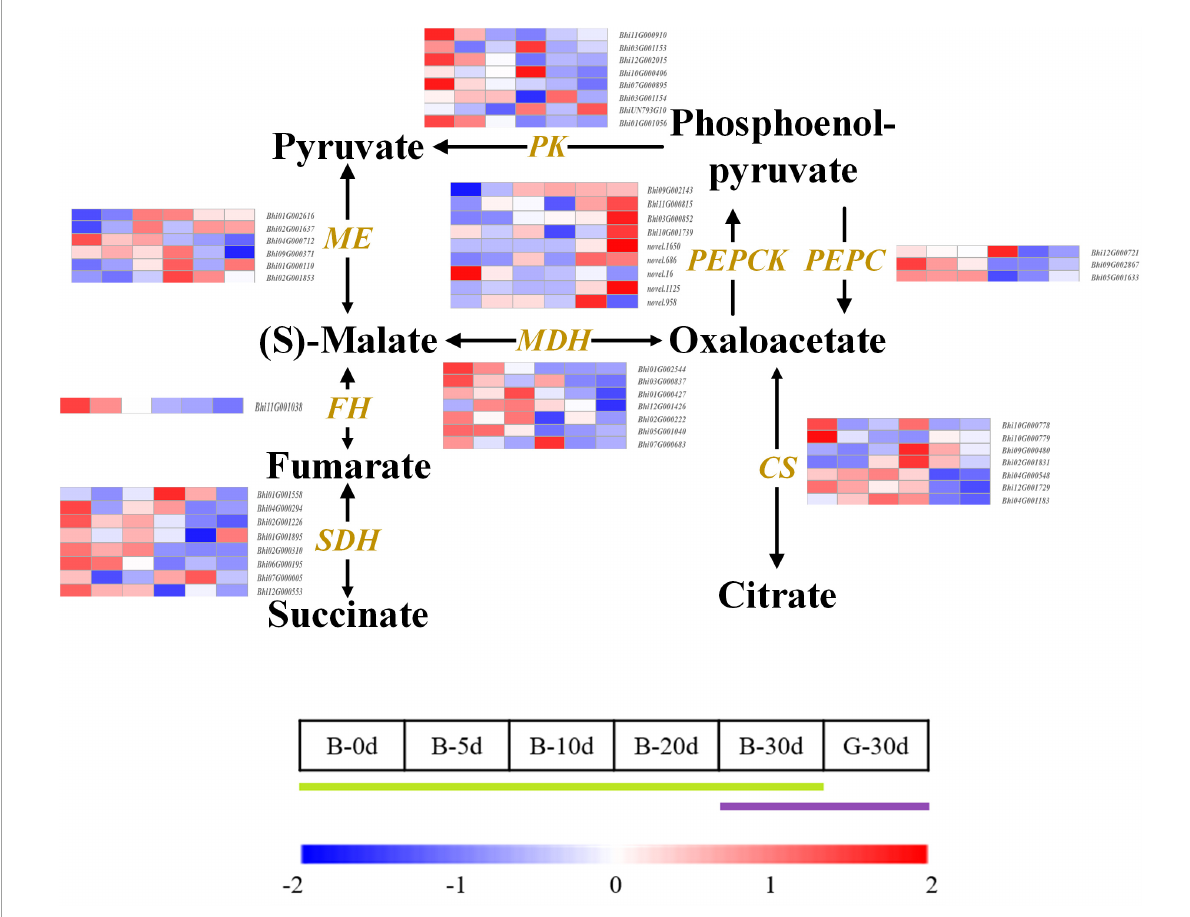
FIGURE5 Developmental expression profiles of genes of organic acid biosynthesis and catabolism in developing wax gourd fruit. PEPC : phosphoenolpyruvate carboxylase; PEPCK : phosphoenolpyruvate carboxykinase; MDH : malate dehydrogenase; ME : malic enzyme; PK : pyruvate kinase; SDH : succinate dehydrogenase; FH : fumarate hydratase; CS : citrate